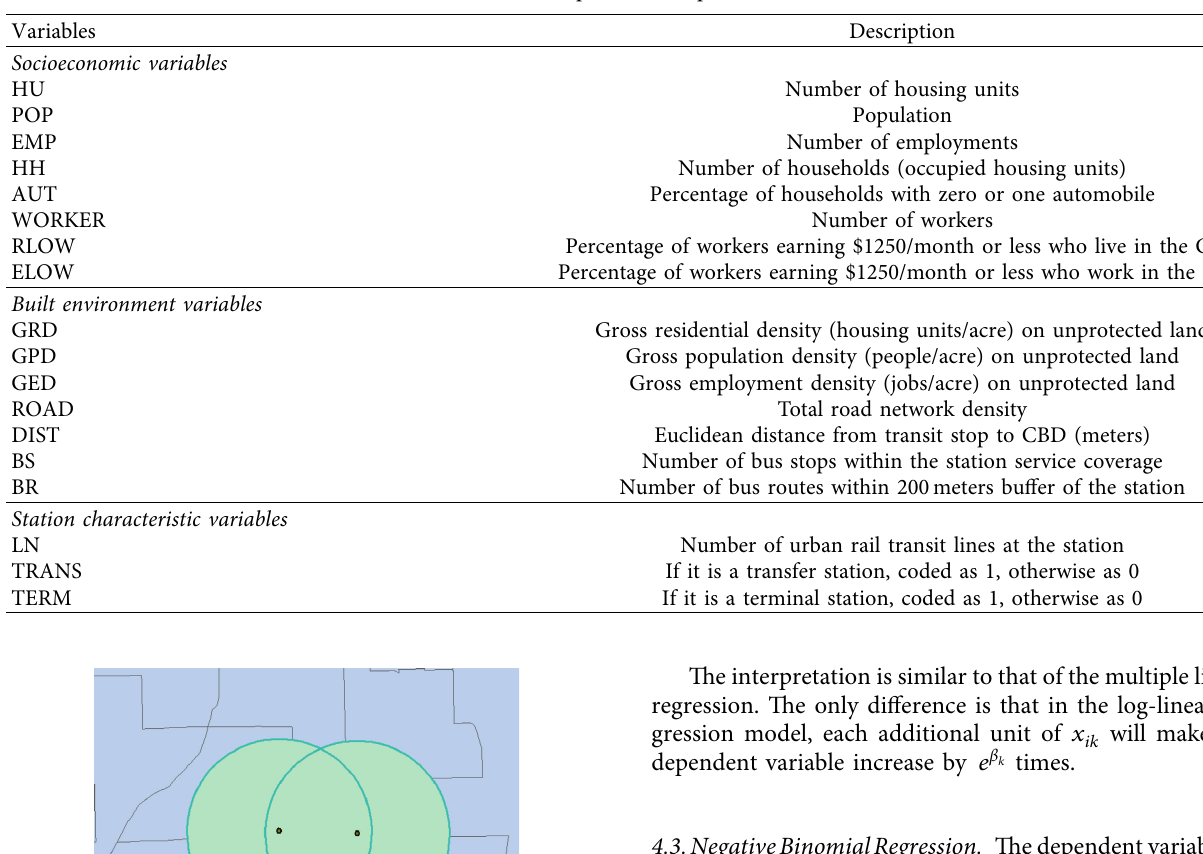
Table 1: The description of independent